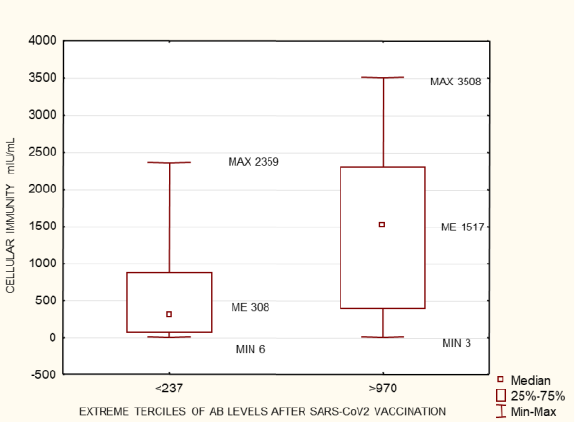
Figure 8. The group of patients with no history of SARS-CoV-2 infection prior to vaccination. Statistically significant differences in cellular immunity between the extreme terciles of post-SARS-CoV-2 vaccination antibody levels <237 AU/mL and >970 AU/mL. p = 1.14 × 10 –11 . Mann–Whitney U test. AB: antibody.